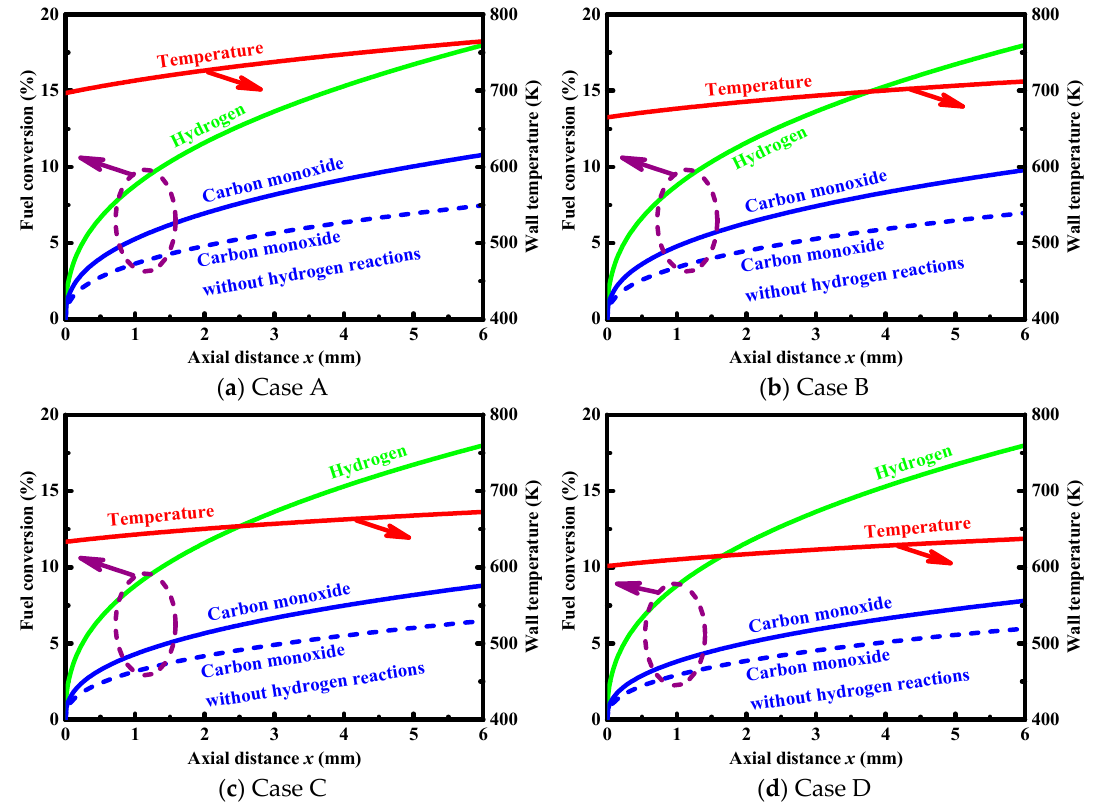
Figure 8. Wall temperature and conversion profiles for Cases A–D shown in Table 2.